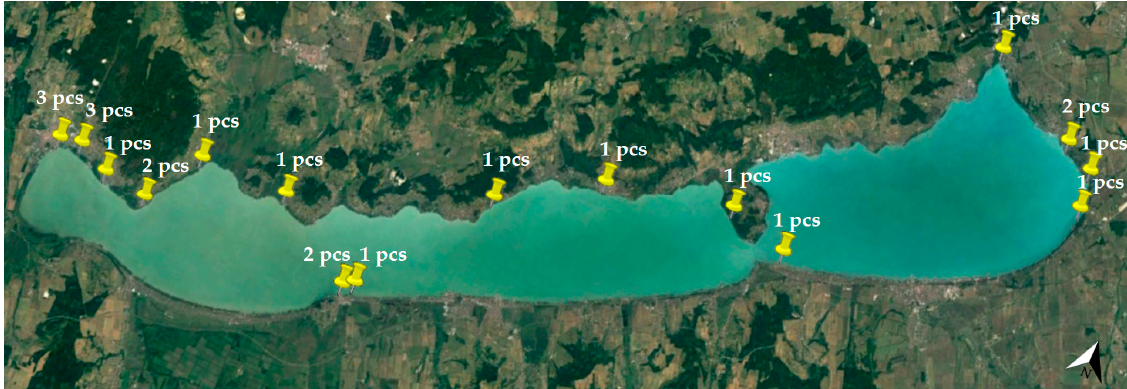
Figure 4. The number of anglers’ ports per town/village at Lake Balaton based on [55].